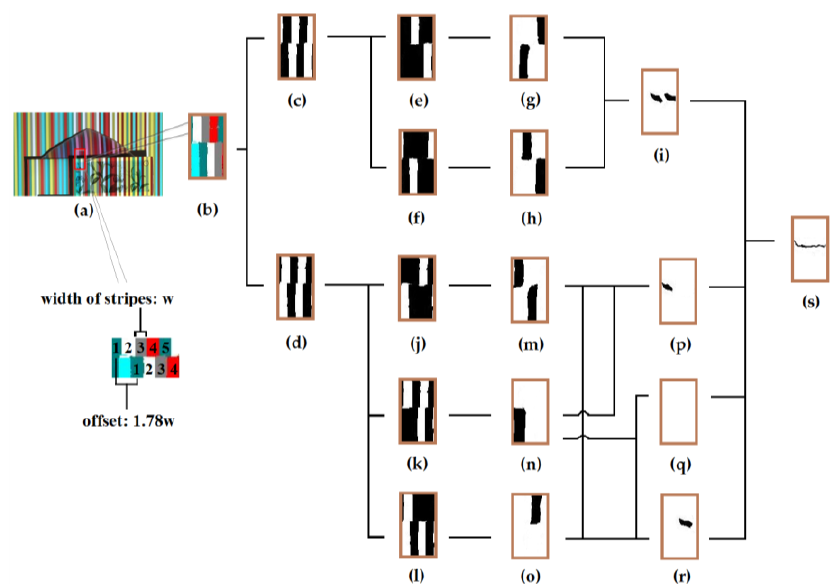
Figure 11. The process of detecting depth edges from the recovered color stripes in a shadow region: ( a ) color stripe pattern image; ( b ) recovered color stripes in the shadow region ( a ); ( c ) binary pattern for dark stripes; ( d ) binary pattern for bright stripes; ( e ) partial pattern without dark cyan stripes; ( f ) partial pattern without gray stripes; ( g ) Gabor response from ( d ); ( h ) Gabor response from ( e ); ( i ) depth edges between dark cyan and gray stripes; ( j ) partial pattern without white stripes; ( k ) partial pattern without cyan stripes; ( l ) partial pattern without red stripes; ( m ) Gabor response from ( j ); ( n ) Gabor response from ( k ); ( o ) Gabor response from ( l ); ( p ) depth edges between cyan and white stripes; ( q ) depth edges between red and cyan stripes; ( r ) depth edges between red and white stripes; and ( s ) depth edges detected as the union of ( i ), ( p ), ( q ) and ( r ).